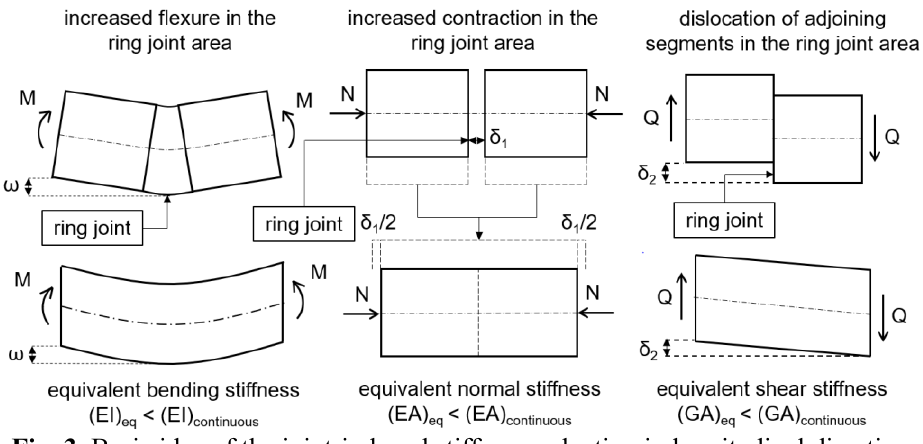
Fig. 3. Basic idea of the joint-induced stiffness reduction in longitudinal